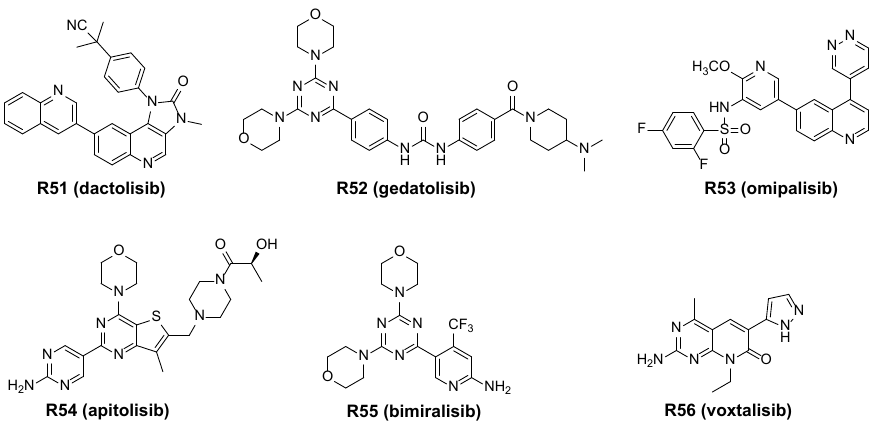
Figure 9. Structures of dual mTOR/PI3K inhibitors.